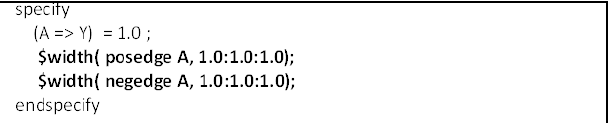
Figure 8. Minimum pulse width check in Verilog